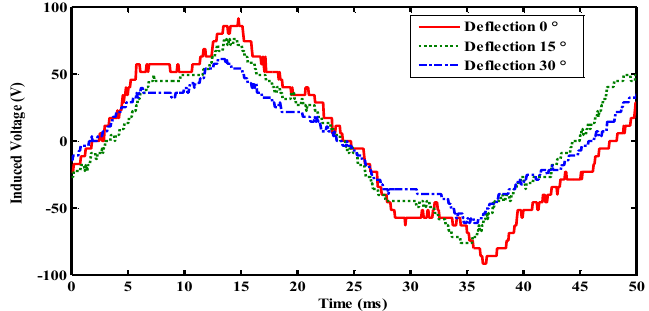
Figure 32. Induced voltage comparison diagram of phase A winding in three states based on the experiment.